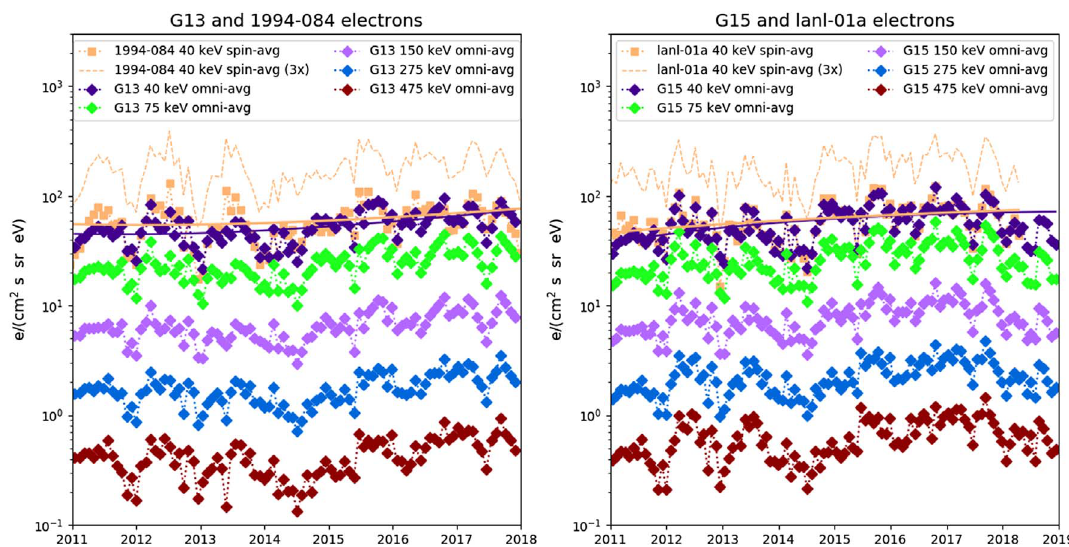
Fig. 9. Bartels-rotation averages of MPA 40 keV electron and MAGED electron fl uxes. (Left) GOES-13 and 1994-084 fl uxes, 2011 – 2017. (Right) GOES-15 and LANL-01A fl uxes, 2011 – 2018. The second-order fi ts to the MPA and MAGED 40-keV electron fl uxes are represented by solid lines. In each panel, the MPA fl uxes are also plotted at three times their magnitude in order to distinguish them from the MAGED fl uxes at the same energy. (The energy unit is converted from keV to eV to be consistent with the Denton et al., 2015, 2016